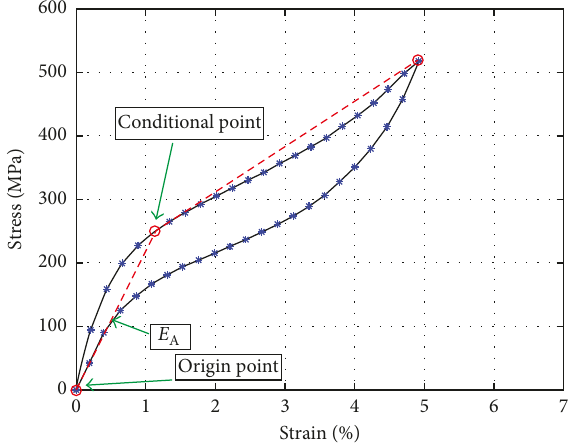
Figure 4: Diagram for the simplified stress-strain curve of superelastic SMA material.